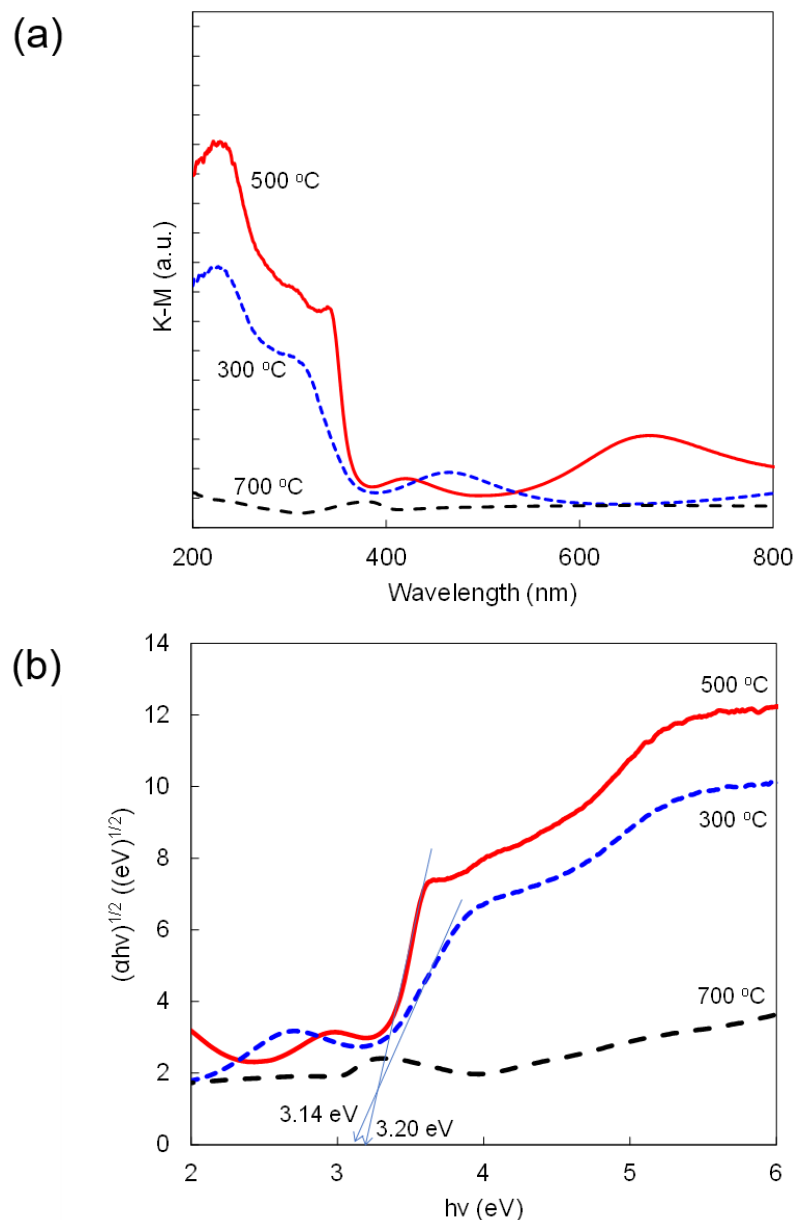
Figure 4. UV–vis Kubelka–Munk transformed diffuse reflectance spectra ( a ) and Tauc plot ( b ). Since Figure 4 . UV – vis Kubelka – Munk transformed diffuse reflectance spectra ( a ) and Tauc plot ( b ). Since the TNTs were subjected to UV–vis analysis after irradiation, the Rh metal was modified onto the the TNTs were subjected to UV – vis analysis after irradiation, the Rh metal was modified onto the surface of TNTs. Calcination temperature: blue line for 300 °C, red line for 500 °C, and black line for surface of TNTs. Calcination temperature: blue line for 300 ◦ C, red line for 500 ◦ C, and black line for 700 °C. 700 ◦